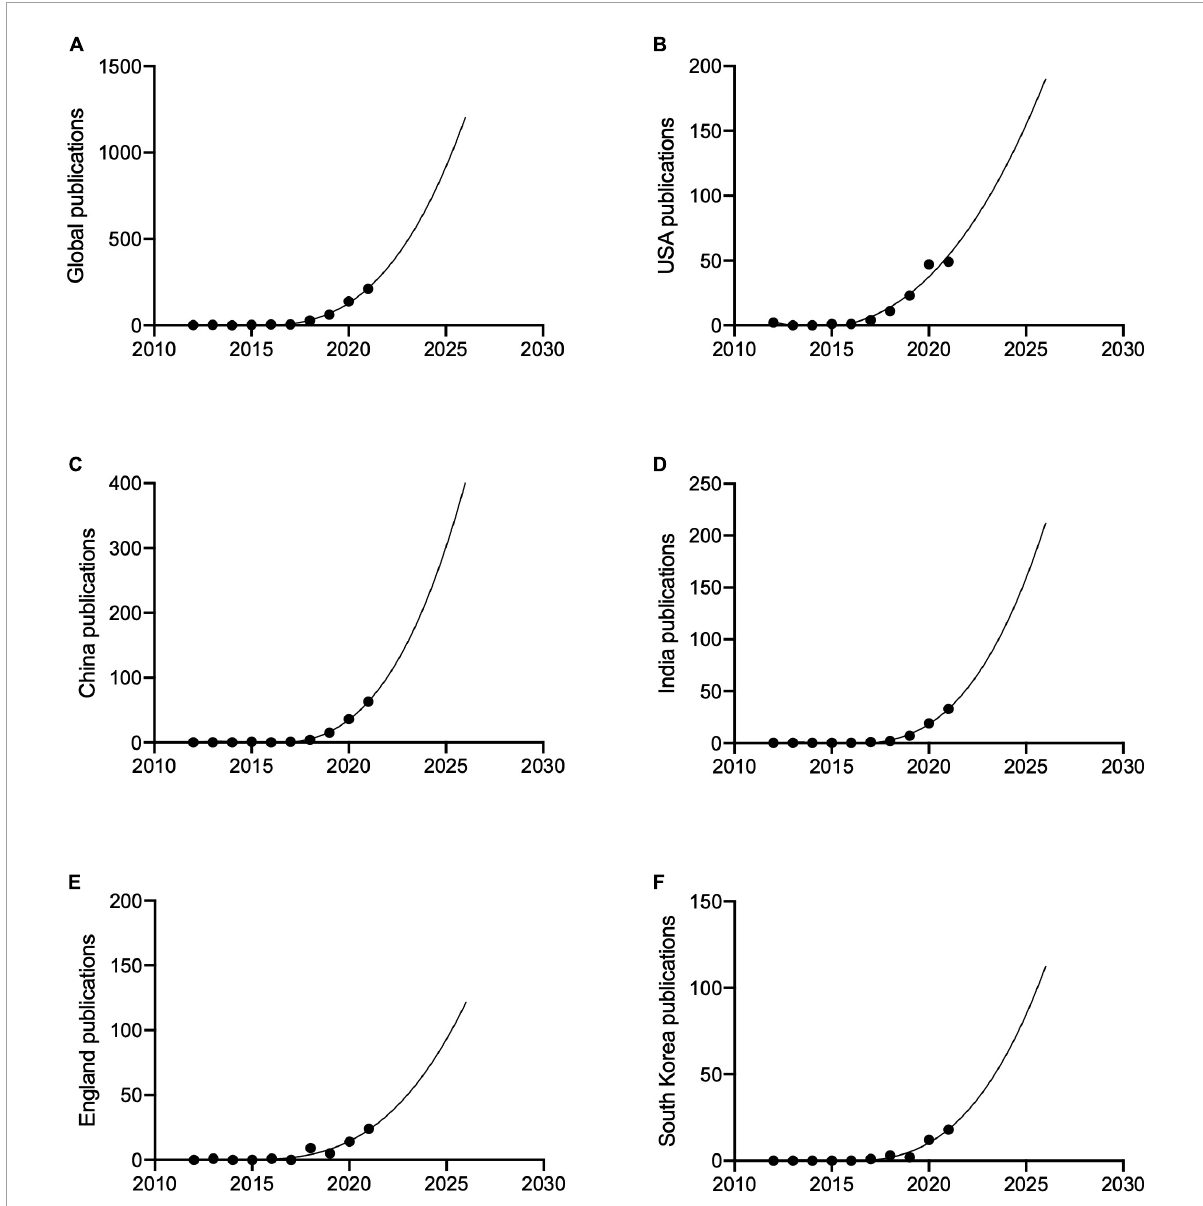
FIGURE2 The publication trends and prediction curve of global and countries which had the most publications since 2012. (A) Global. (B) USA. (C) China. (D) India. (E) England. (F) South